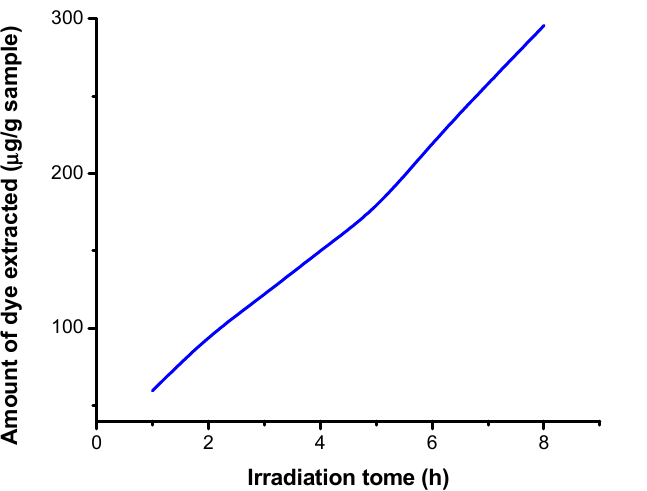
Figure 14. Dependence of the extracted 5% dye concentration on the irradiation time in an acid medium.